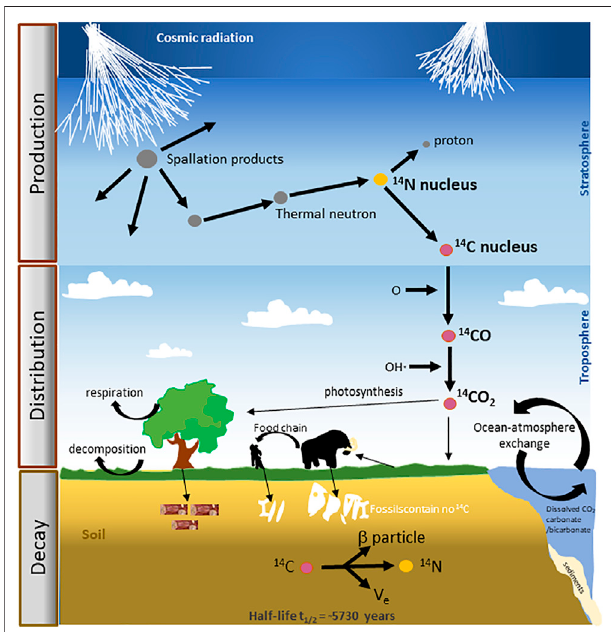
FIGURE 1 | The schematic of mechanisms showing production-to- decay of radiocarbon ( 14 C). This. can be brie fl y explained in four steps: 1) Cosmic rays bombard the upper atmosphere and send a. cascade of neutrons. 2) Upon striking atoms of nitrogen, the main component of Earth ’ s atmosphere, they transform some of 14 N into Carbon-14 or 14 C. 3) Carbon-14 creates radioactive. Carbon dioxide by readily combining with oxygen in the atmosphere which is then absorbed in the. biosphere by plants and enters the food chain. 4) Upon death and burial, the